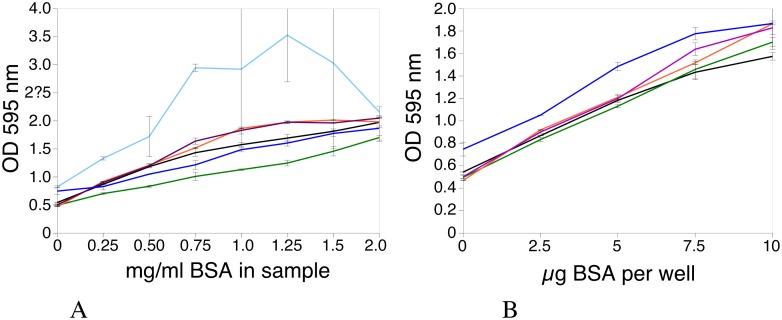
Protein assay in the microplate format (250μl).BSA dilutions were assayed using the microplate format. Black: 10 μl of BSA dilutions in water. Green: 5 μl of BSA dilutions in SDS buffer, reagent made by adding 10 μl alpha-cyclodextrin solution (125 mg/ml) to 240 μl of Bradford reagent. Orange: 10 μl of BSA dilutions in SDS buffer, reagent made by adding 20 μl alpha-cyclodextrin solution (125 mg/ml) to 230 μl of Bradford reagent. Brown: 10 μl of BSA dilutions in SDS buffer, reagent made by adding 20 μl alpha-cyclodextrin solution (125 mg/ml) to 105 μl of water and 125 μl of 2× concentrated Bradford reagent. Blue: 5 μl of BSA dilutions in RIPA buffer, reagent made by adding 20 μl alpha-cyclodextrin solution (125 mg/ml) to 230 μl of Bradford reagent. Light blue: 10 μl of BSA dilutions in RIPA buffer, reagent made by adding 40 μl alpha-cyclodextrin solution (125 mg/ml) to 85 μl of water and 125 μl of 2× concentrated Bradford reagent. This special reagent was tried to normalize the response of the assay to 10μl RIPA buffer. In panel A, the abscissae values are the concentration of BSA (in mg/ml) of the sample, which can be of 5 or 10μl size depending on the assay conditions. In panel B, the abscissae values are the amount of BSA per well.